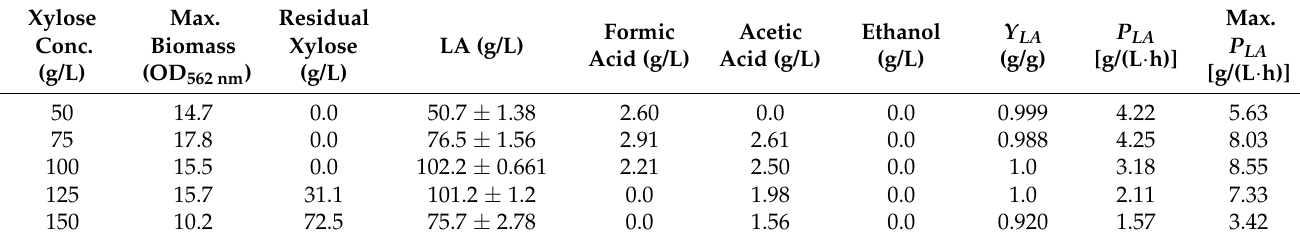
Table 2. Effect of xylose concentrations on lactic acid production by B. coagulans Azu-10. Xylose